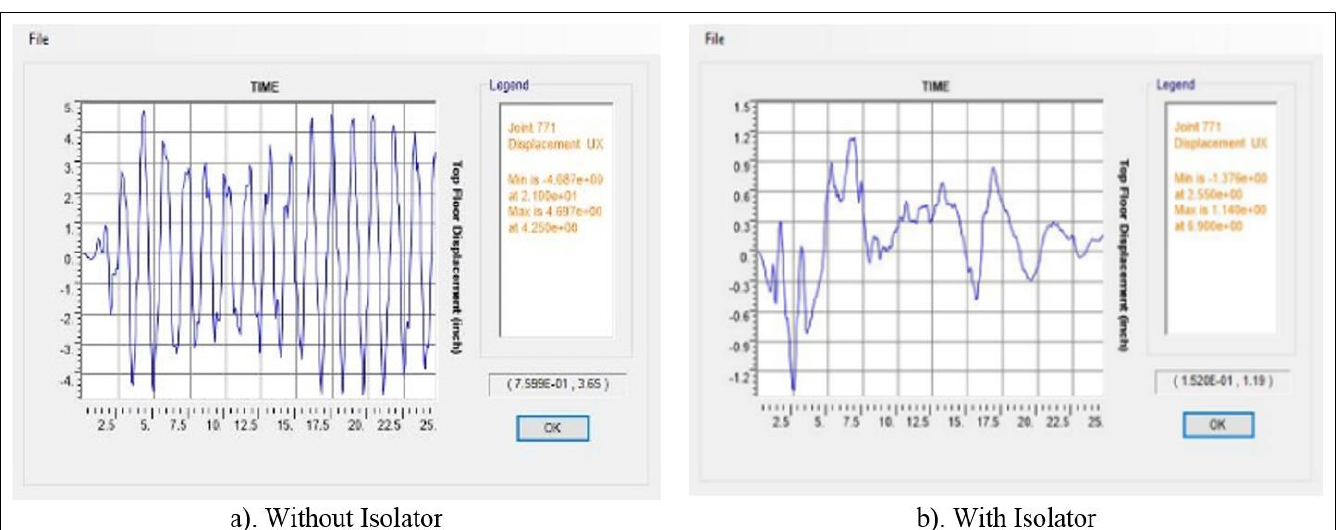
Figure 9: Top floor displacement vs time curve (25 sec).